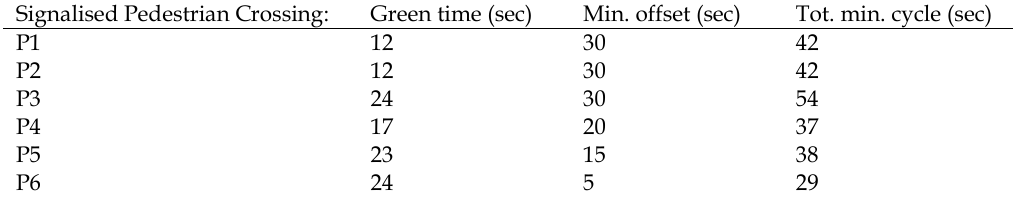
Table 1. Pedestrian traffic light settings Signalised Pedestrian Crossing: Green time (sec) Min. offset